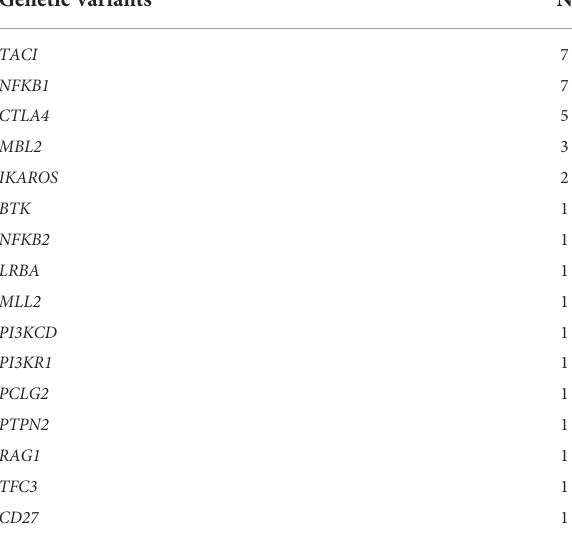
TABLE 1 List of genetic variants in the Spanish GTEM-SEMI-CVID Registry. Genetic